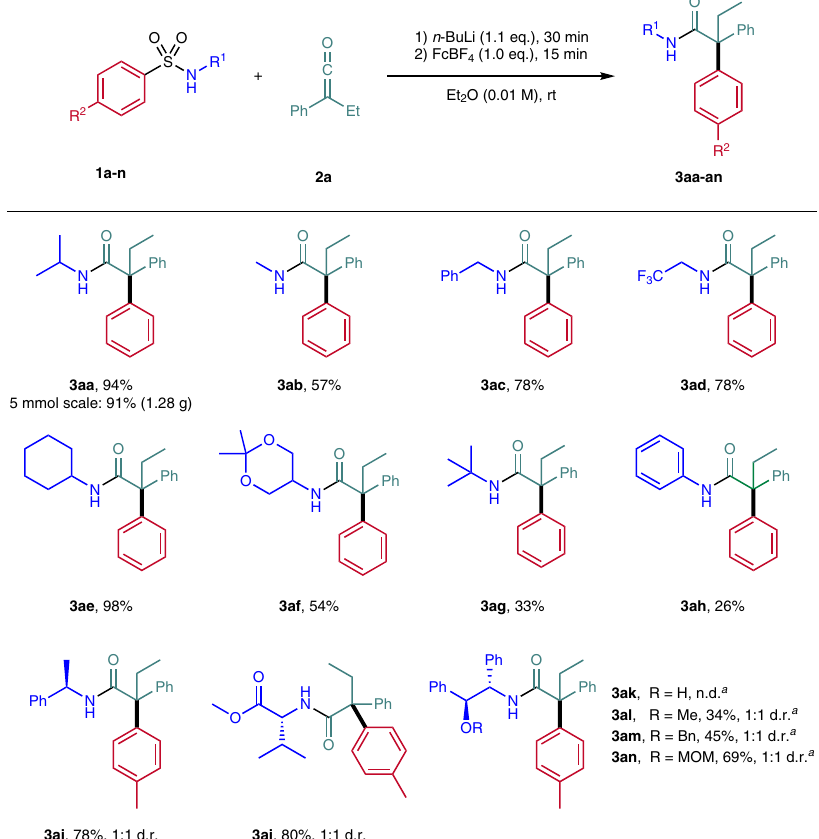
Fig. 2 Variation of the N -substituent in the arylsulfonamide. Reaction scale: 0.200 mmol. n.d. = not detected. d.r. = diasteromeric ratio. FcBF 4 = Ferrocenium tetra fl uoroborate. Ketene 2a in Et 2 O (0.06 M ) over 30 min by syringe pump. a LiCl (7.0 eq.) was